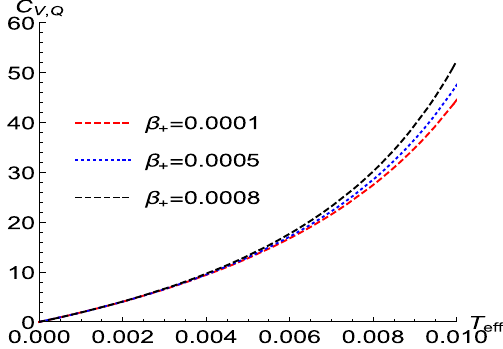
Fig. 9 Curves of C P